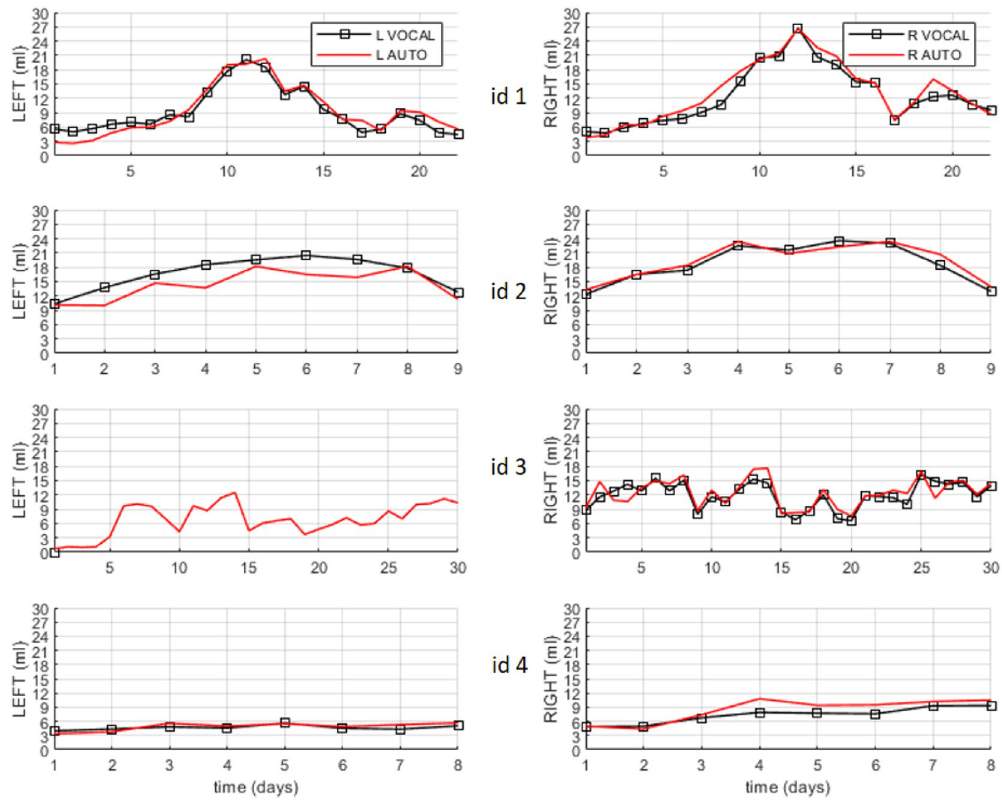
Figure 2. Temporal series acquired over several days of the left (L) and right (R) brain ventricle volumes of four patients (id1–id4). In total, the four series sum 69 3D US. The curves with squared markers are the volumes measured using the gold standard, VOCAL. The curves without markers are the measurements obtained with automatic segmentation. Using VOCAL, there are situations in which the ventricles cannot be measured like the left ventricle of patient